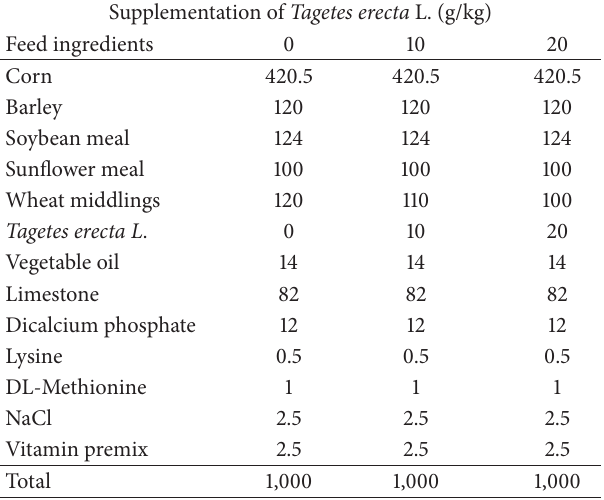
Table 1: Composition of the experimental diets 1 (as dry-matter